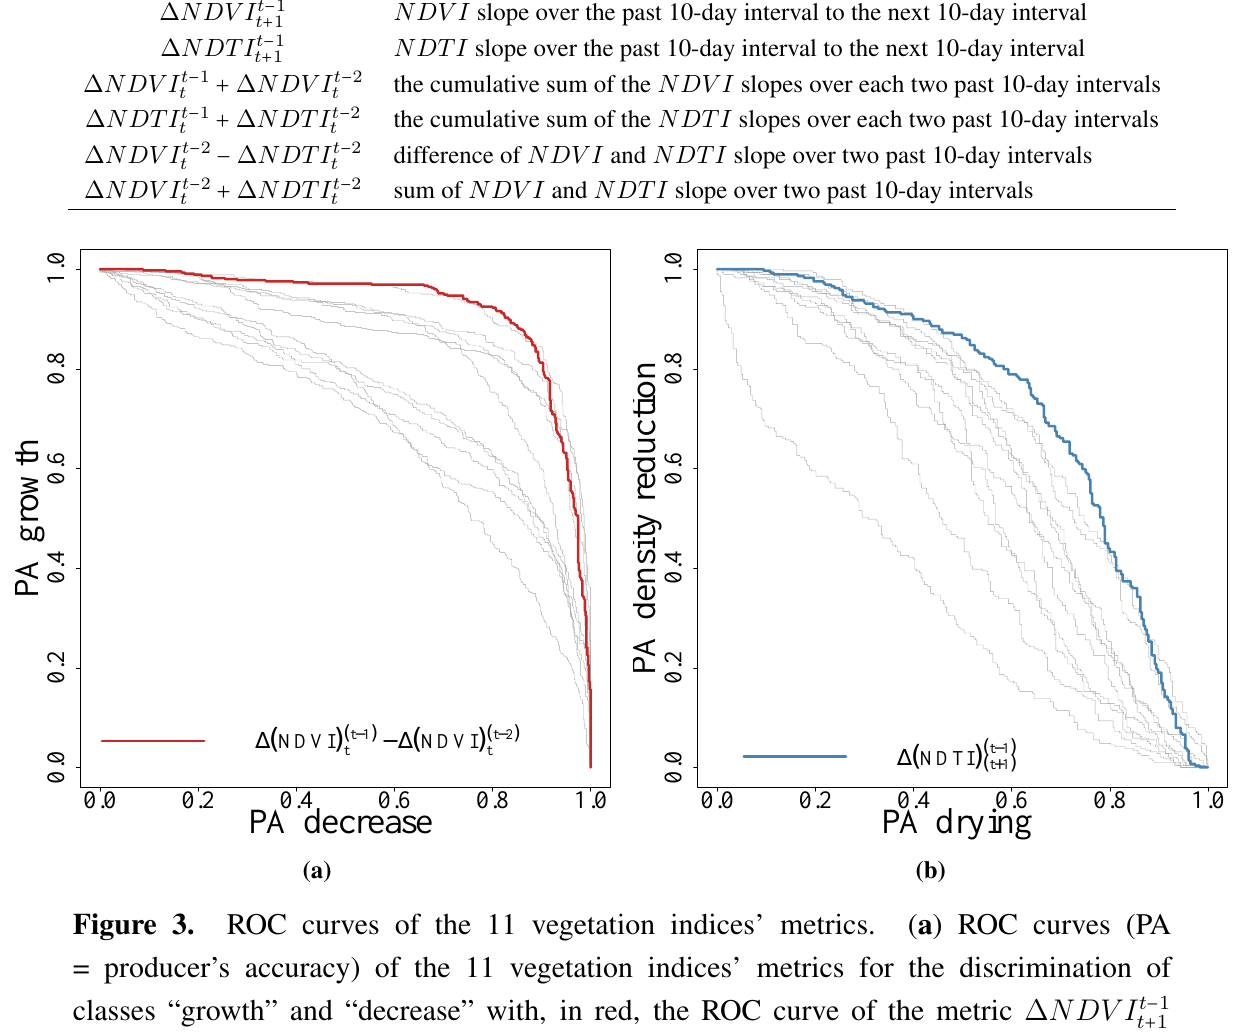
Figure 3. ROC curves of the 11 vegetation indices’ metrics. ( a ) ROC curves (PA = producer’s accuracy) of the 11 vegetation indices’ metrics for the discrimination of classes “growth” and “decrease” with, in red, the ROC curve of the metric ∆ NDV I t − 1 t + 1 ( i.e. , accumulated slopes of NDVI over two 10-day intervals). ( b ) ROC curves of the 11 metrics for the discrimination of classes “density reduction” and “drying” with, in blue, the ROC curve of the metric ∆ NDT I t − 1 ( i.e. , NDTI slope calculated with a delay of one t + 1 10-day